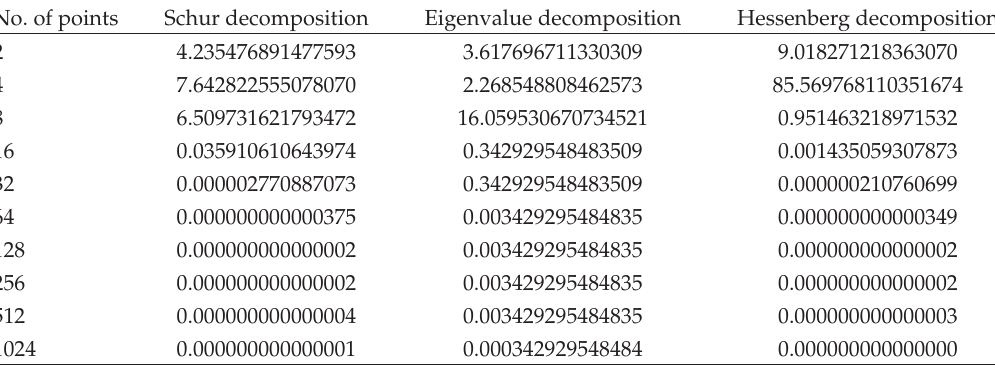
Table 3: Comparison absolute error for di ff erent numbers of points for di ff erent matrices. No. of